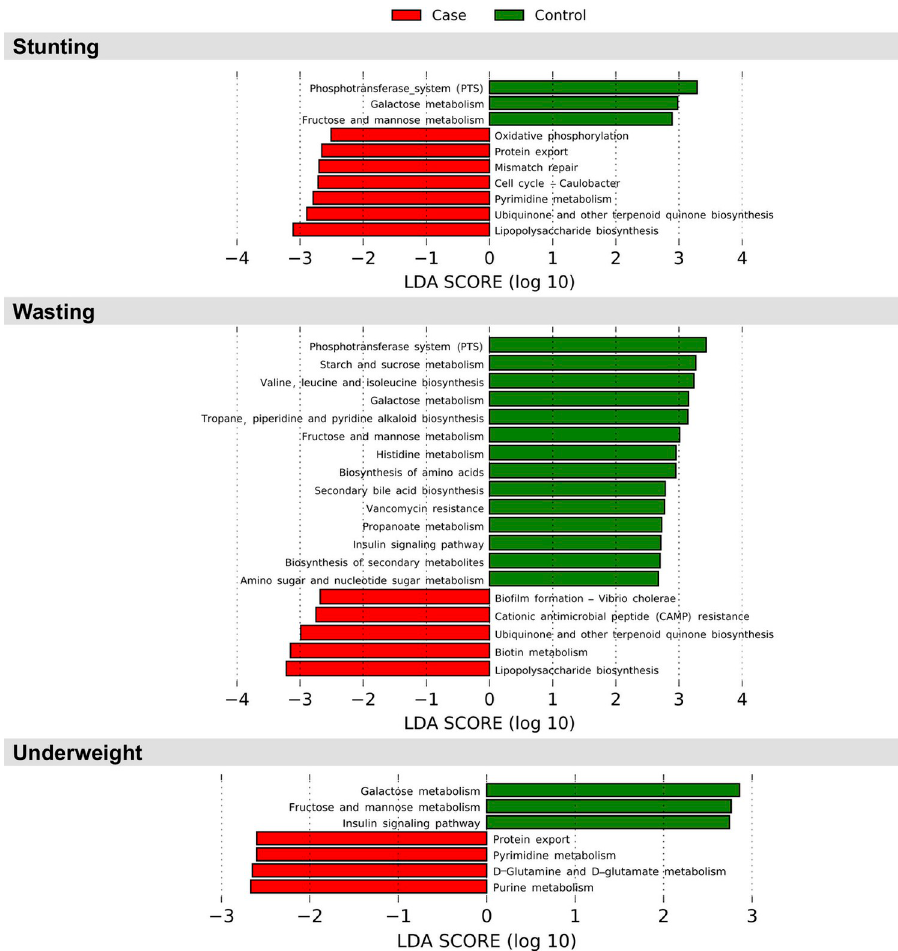
Fig 4. Predicted microbial pathways (KEGG) of stunting, wasting and underweight in 18–24 month old Indian children. A summary of differential abundant microbial pathways (KEGG) predicted in stunted, wasted and undernourished children using the linear discriminant analysis (LDA) Effect Size (LEfSe) tool. An LDA cut-off score of 2 or greater and unadjusted p-value threshold of 0.05 was used to report the significant findings.